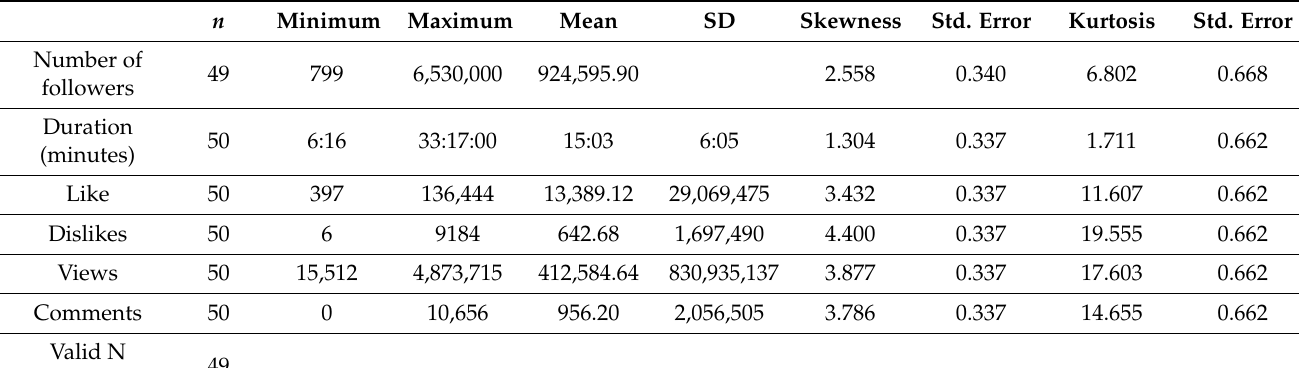
Table 2. General